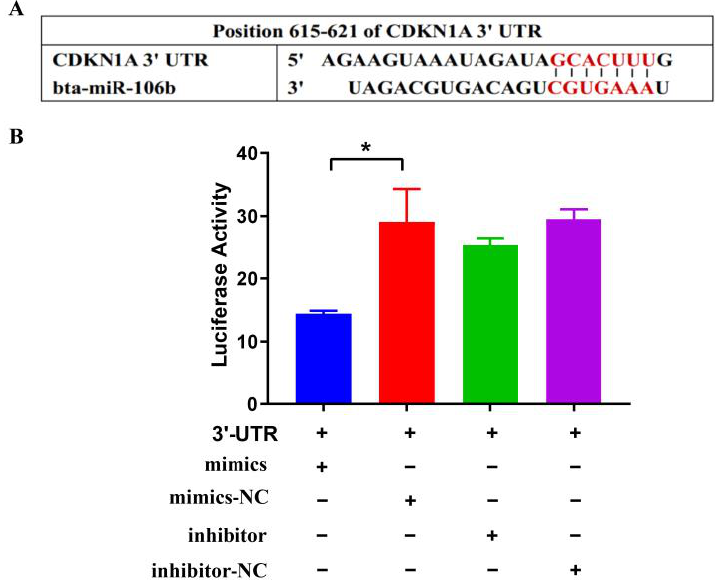
Figure 1. Bta-miR-106b regulated transcript activity by targeting CDKN1A 3′UTR with luciferase assays. ( A ) It was predicted Bta-miR-106b targeted the 3 ′ UTR of bovine CDKN1A with TargetScan. ( B ) Luciferase activity was down-regulated after co-transfecting 3 ′ UTR of CDKN1A with Bta-miR- 106b mimics. (Note: * means p value < 0.05; ** means p value < 0.01 . )